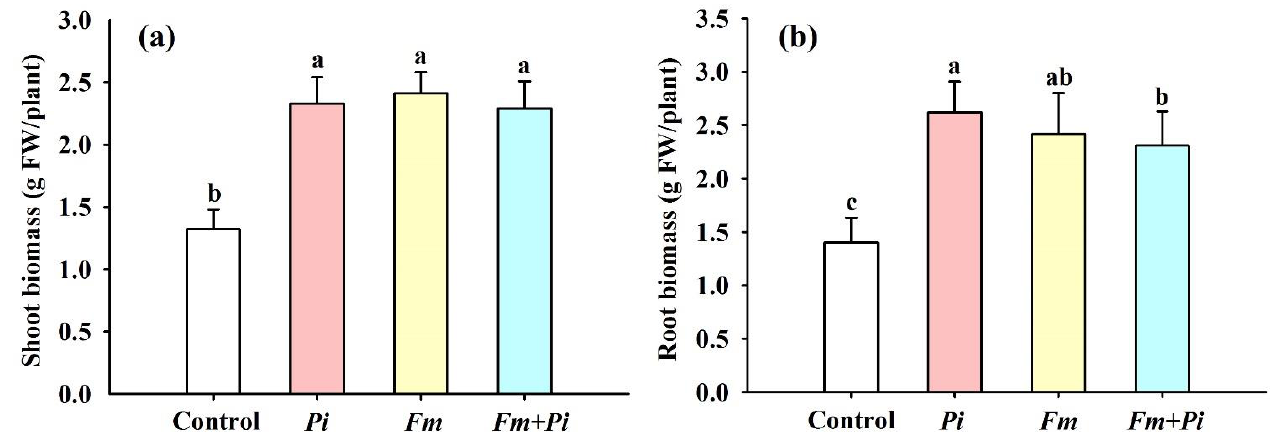
Figure 3. Effects of Piriformospora indica ( Pi ) and Funneliformis mosseae ( Fm ) singly and in combination on shoot ( a ) and root ( b ) biomass of trifoliate orange seedlings. Data (means ± SD, n = 10) followed by different letters above the bars indicate significant differences ( p < 0.05) between treatments.